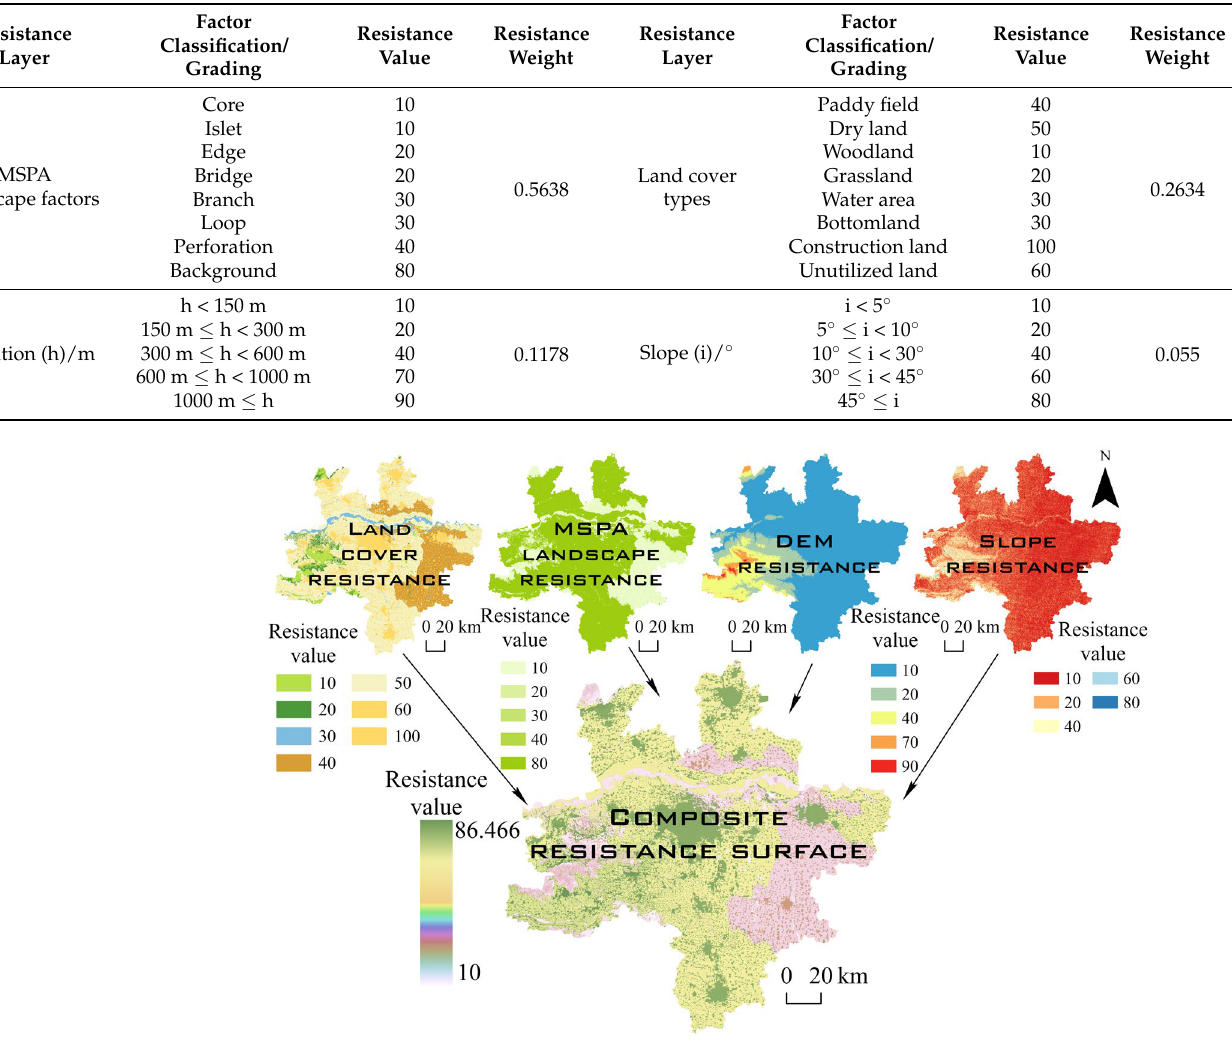
Figure 4. Synthesis of resistance surface formation.